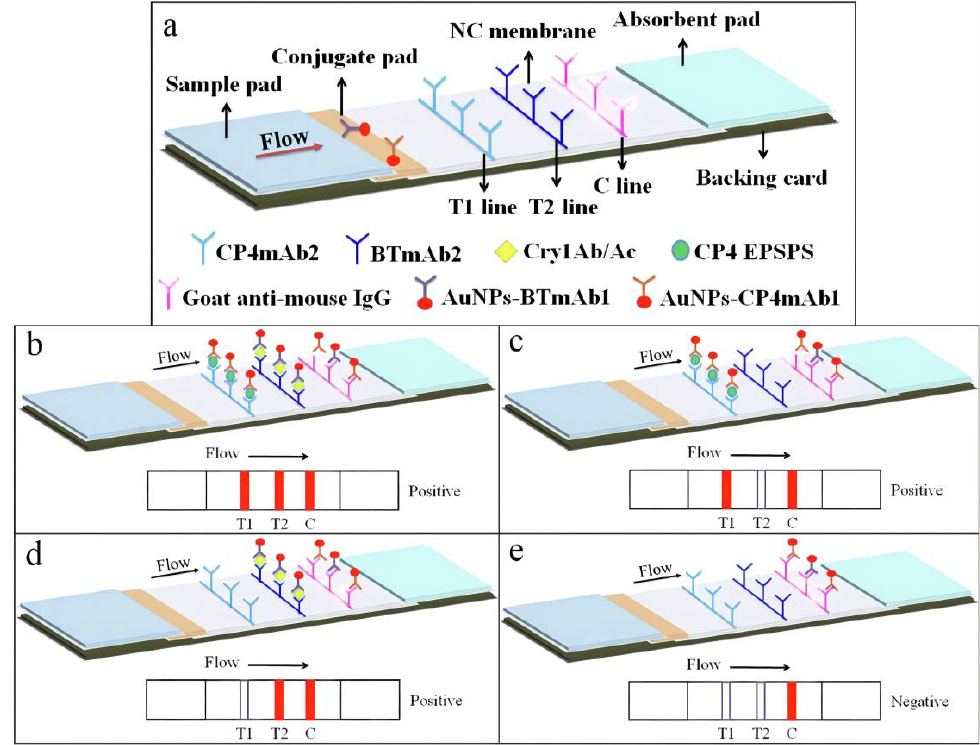
Figure 1. A colloidal Au immunochromatographic strip for the simultaneous detection of numerous transgenic proteins [13]. Structure and composition of the ICS ( a ); Double positive result of the strip ( b ); Single positive result of the strip ( c , d ); Negative result of the strip ( e ).